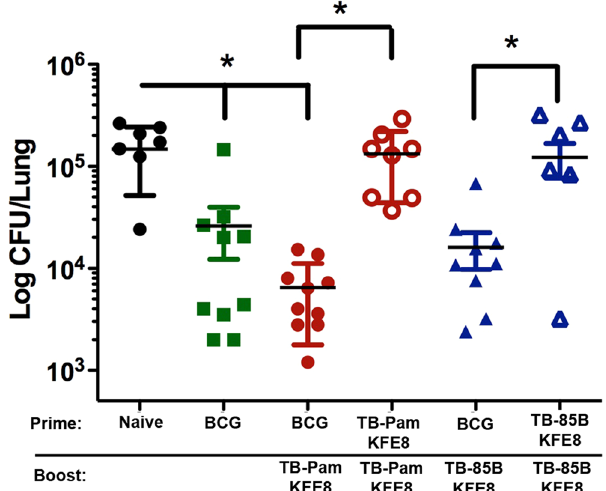
Figure 7. Boosting BCG-primed mice with peptide nanofiber vaccines leads to reduction of lung bacterial load. CFU enumeration data indicated significantly reduced lung bacterial loads and reduced liver dissemination (data not shown) in mice treated with BCG or primed with BCG and boosted with co-assembled nanofibers of Pam2Cys-KFE8 and TB10.4-KFE8 compared to untreated mice. Boosting with co-assembled nanofibers of Pam2Cys-KFE8 and TB10.4-KFE8 led to an additional 0.5 log 10 CFU reduction in lung bacterial load compared to BCG alone. Prime-boost with peptide nanofiber vaccines in the absence of BCG priming did not lead to